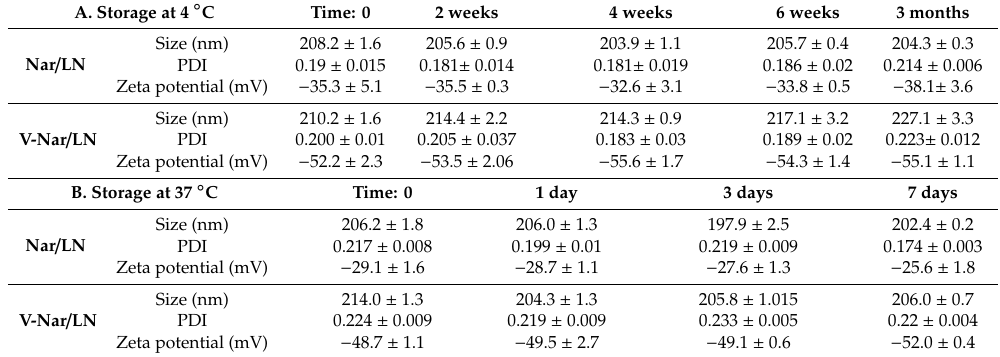
Table 2. Summary of dimensions and zeta potential for naringenin-loaded non-targeted (Nar / LNs) and targeted (V-Nar / LNs) nanoemulsions, upon storage at 4 ◦ C for di ff erent time intervals up to 6 weeks (A) and at 37 ◦ C up to 1 week (B).